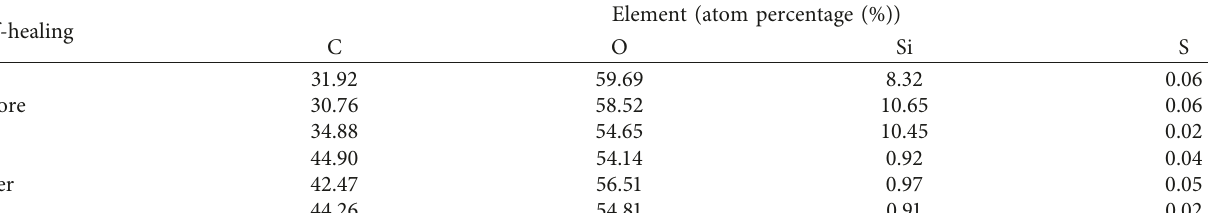
Table 6: EDS analysis results of self-healing products.